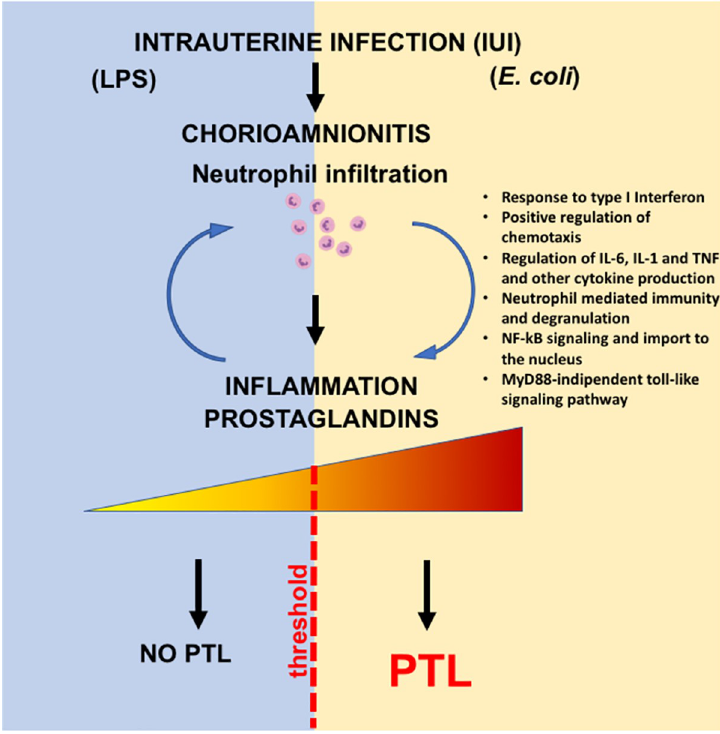
Fig 8. Working model: IUI is a major risk factor for PTL. Chorioamnionitis is the hallmark feature of IUI and is typically characterized by the infiltration of neutrophils into the fetal membranes. Evidence suggests that the extent of bacterial colonization, route of infection, and the stimulatory capacity of the bacteria all play key roles in the activation of pro-inflammatory signaling cascades that induce production of pro-inflammatory cytokines (e.g., IL-6) and chemokines (e.g., CCL2). The intensity of immune response is a key player for the outcome of the pregnancy, which, in turn, promote prostaglandin production leading to PTL. IL-1, interleukin 1; IL-6, interleukin 6; IUI, intrauterine infection/inflammation; NF-kB, nuclear factor kappa B; PTL, preterm labor; TNF, tumor necrosis factor.